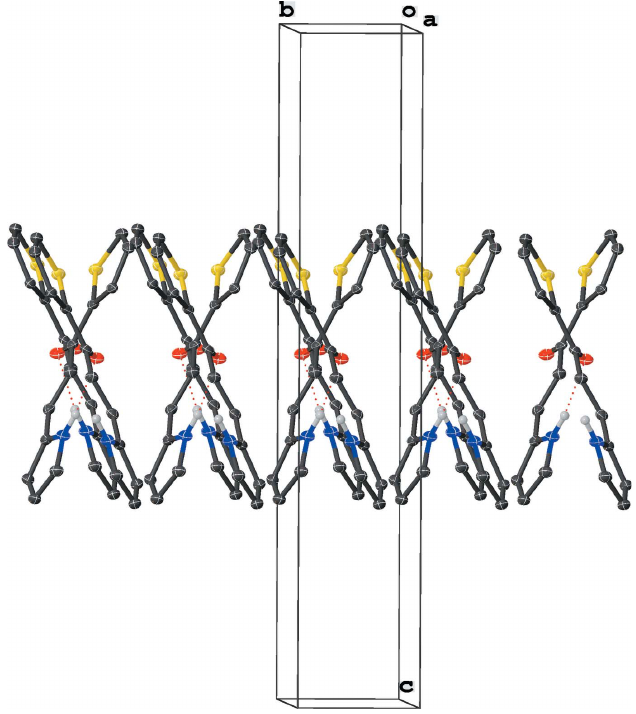
Figure 3 View of the X-pattern in the packing, viewed approximately along the a axis. Displacement ellipsoids are drawn at the 50% probability level.